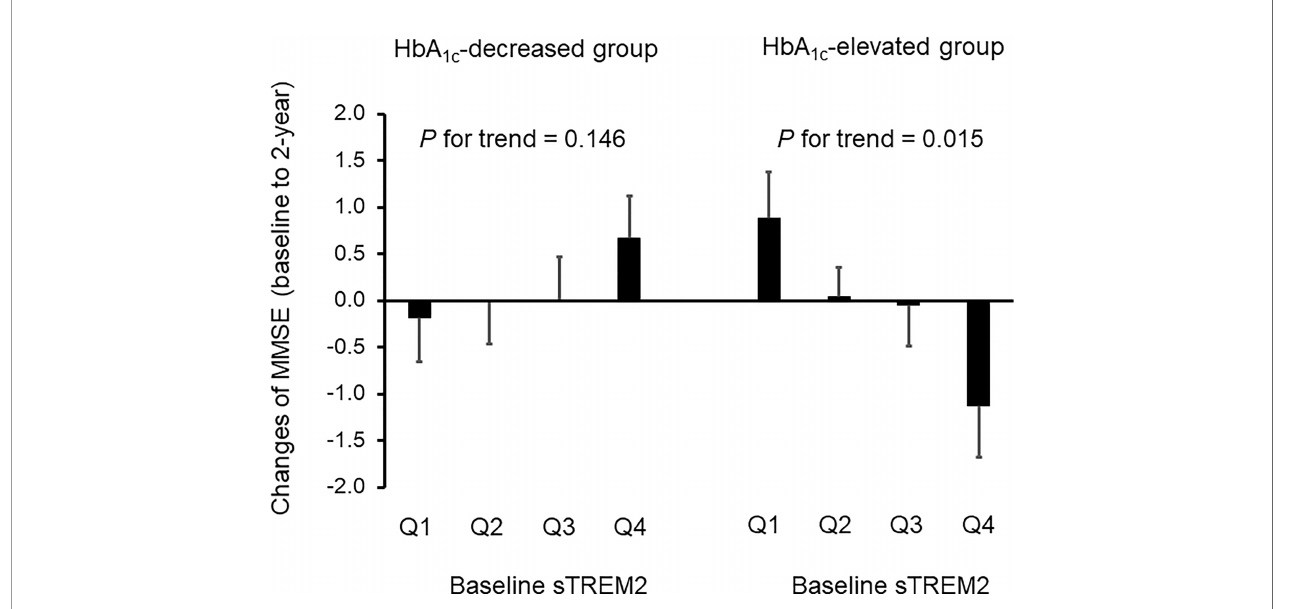
FIGURE 2 | Effects of serum sTREM2 levels at baseline on cognitive impairment at 2-year follow-up in patients with adequately and inadequately controlled type 2 diabetes. The serum sTREM2 levels at baseline were divided into four categories for the HbA 1c -decreased group (Q1, 16.2 – 121.0 pg/mL; Q2, 121.1 – 218.3 pg/mL; Q3, 218.4 – 407.7 pg/mL; Q4, 407.8 – 1223.5 pg/mL) and the HbA 1c -elevated group (Q1, 10.7 – 141.5 pg/mL; Q2, 141.6 – 244.7 pg/mL; Q3, 244.8 – 441.3 pg/mL; Q4, 441.4 – 1728.4 pg/mL). Data are expressed as mean ± standard error. HbA 1c , hemoglobin A 1c ; MMSE, mini-mental state examination; sTREM2, a soluble form of triggering receptor expressed on myeloid cells 2. P -values for trend tests were adjusted for age and